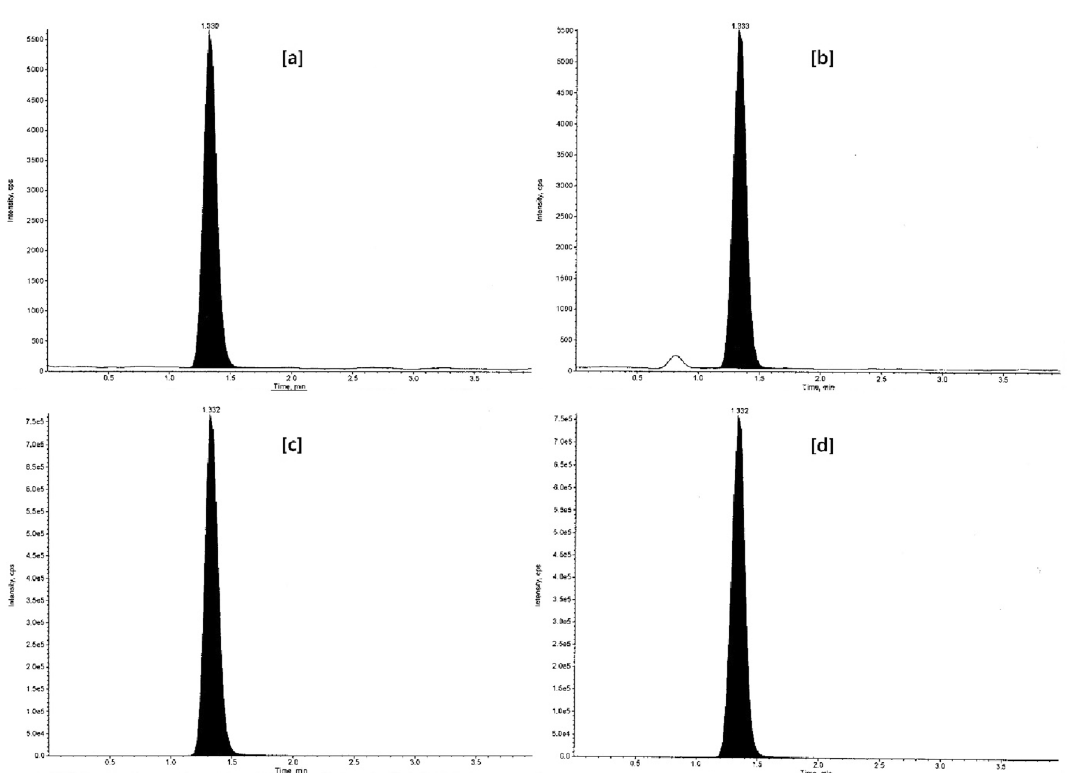
Figure 8. Representative chromatograms of venlafaxine at ( a ) LQC (spiked), ( b ) LQC (pure standard solution), ( c ) HQC (spiked), and ( d ) HQC (pure standard solution)